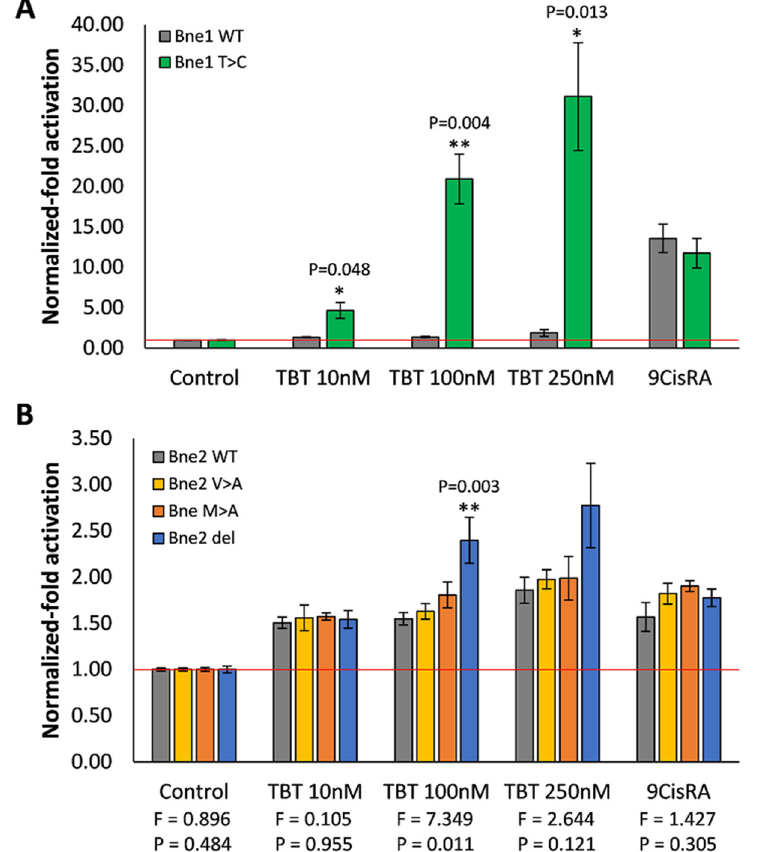
Figure 5. Transactivation activity of the luciferase reporter gene mediated by B. neritina RXRs in COS-1 cells in the presence of 9cisRA and TBT. A B. neritina RXR1 wild-type (Bne1 WT) versus B. neritina RXR1 mutant Thr388Cys (Bne2 T > C); B B. neritina RXR2 wild-type (Bne2 WT) versus B. neritina RXR2 mutants Met231Ala (Bne2 M > A), Val294Ala (Bne2 V > A), and ∆ Ser211 – Asp227 (Bne2 del).